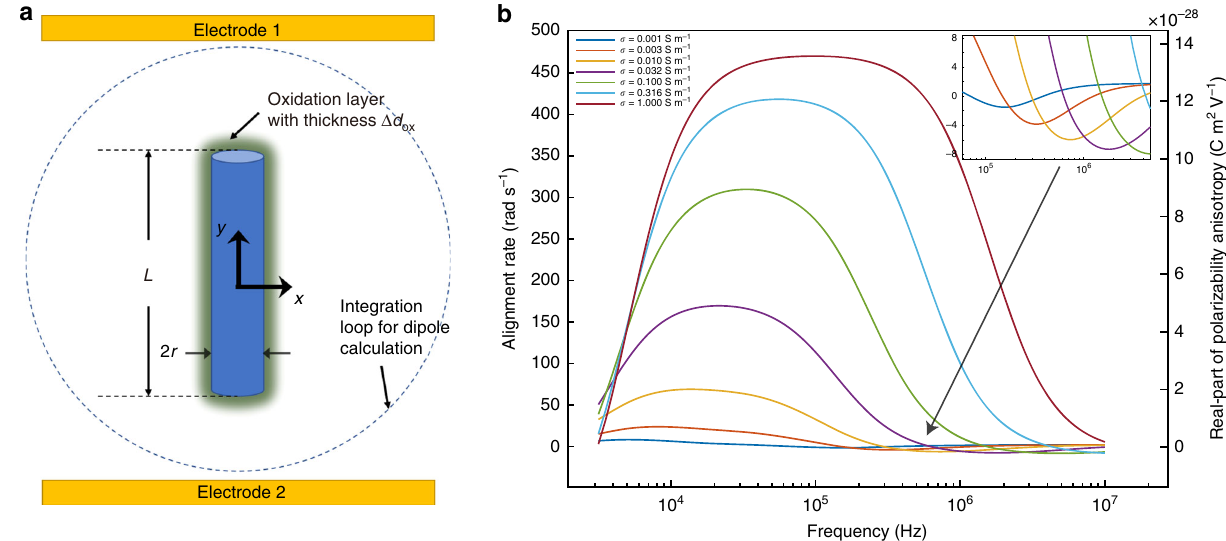
Fig. 3 Modeling of nanowire polarization and numerical calculation of alignment rate versus AC frequency of a silicon nanowire of L = 10 μ m and r = 250 nm. a Model of a silicon nanowire as a cylinder with length L and radius r . An Oxidation shell with thickness Δ d ox = 1 nm is considered, shown as the dark shade surrounding the nanowire. b Numerical calculation of alignment rate of nanowires of different electrical conductivities versus AC frequency. Inset: zoom-in image at frequencies with negative alignment